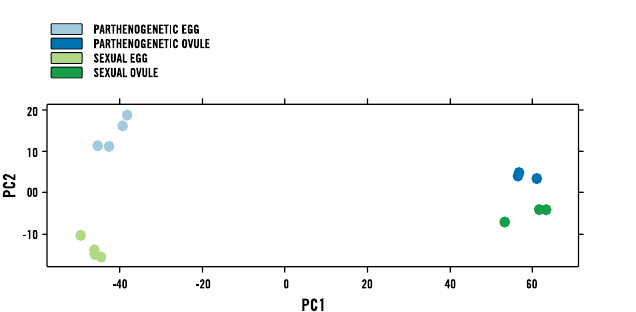
Figure 4. PCA plot of expression profiles across all sequenced samples. The plot is based on the log- transformed CPM (count per million) of read counts (PC1 = 0.4137, PC2 =